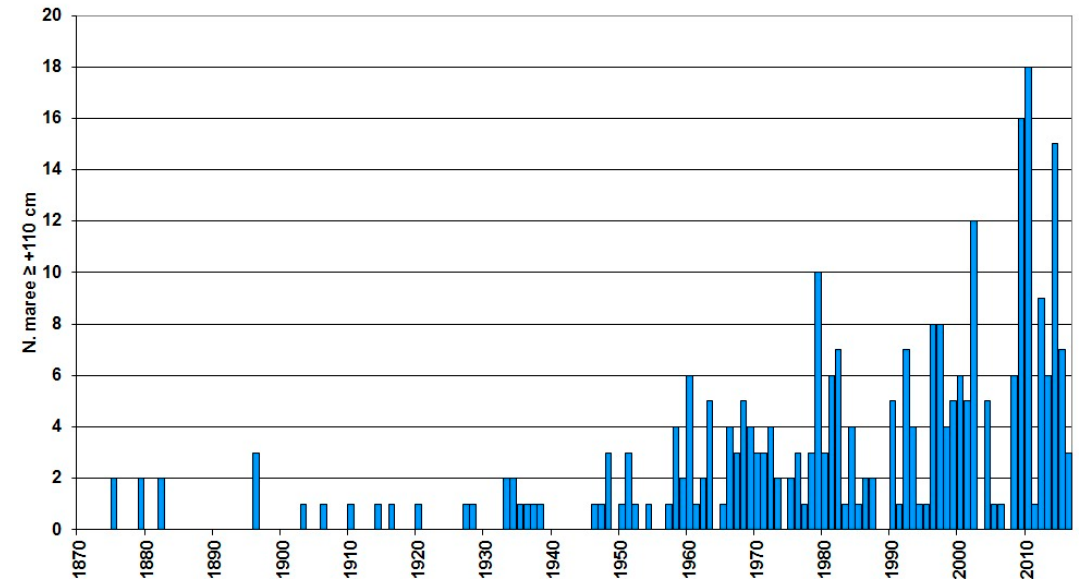
Figure 7. Annual distribution of high tides ( ≥ 110 cm) recorded in Venice from 1872 to 2016 [60].